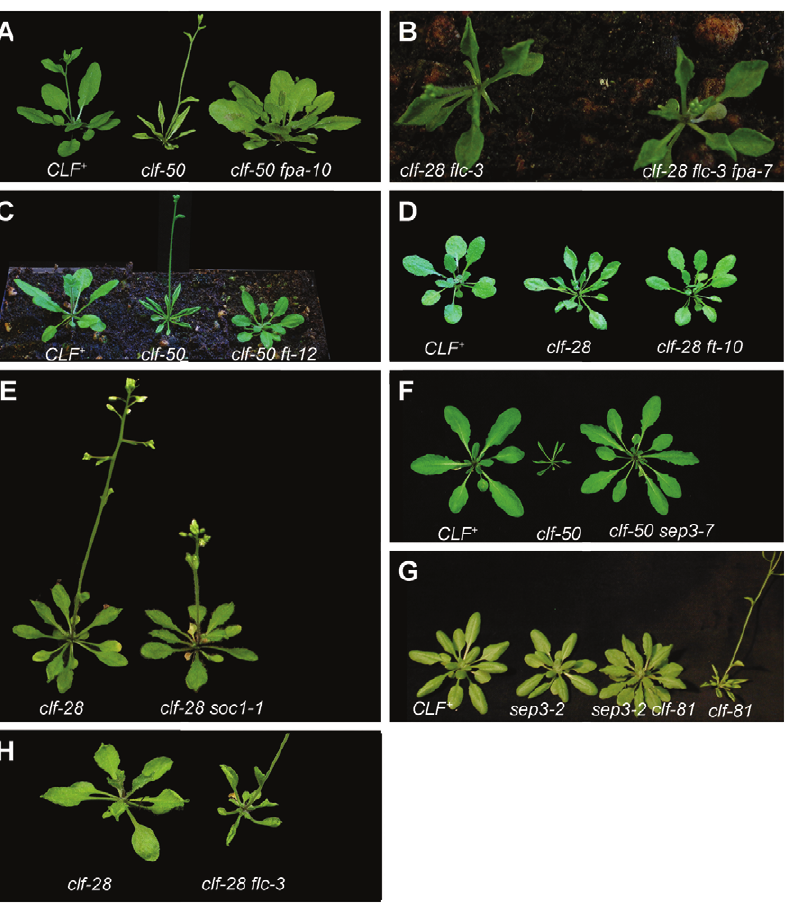
Figure 1. Mutants suppressing the clf phenotype. Rosettes of four week old plants that were grown in long day [except ( G ), short day grown plants], at which time the early flowering and leaf curling of clf mutants is easily seen. ( A ) The fpa mutation suppresses the leaf curling and early flowering of clf-50 and results in late flowering. ( B ) the clf-28 flc-3 fpa-7 triple mutant resembles clf-28 flc-3 mutants and shows early flowering and leaf curling. FLC activity is therefore required for the suppression of clf by fpa . ( C, D ) ft mutations also suppress clf mutations and cause late flowering. ( E ) soc1 mutations do not suppress the early flowering and mild leaf curling of clf-28 mutants. (F, G) sep3 mutations suppress the clf phenotype. ( H ) the flc-3 mutation enhances the leaf curling, small size and early flowering of clf-28